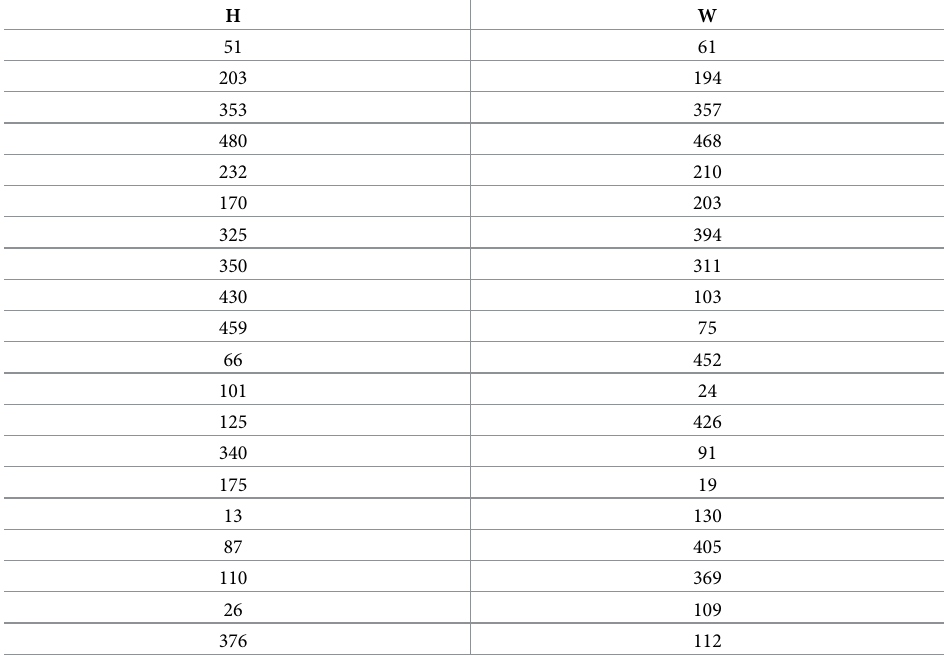
Table 2. The results of aspect ratio obtained after k-means clustering.